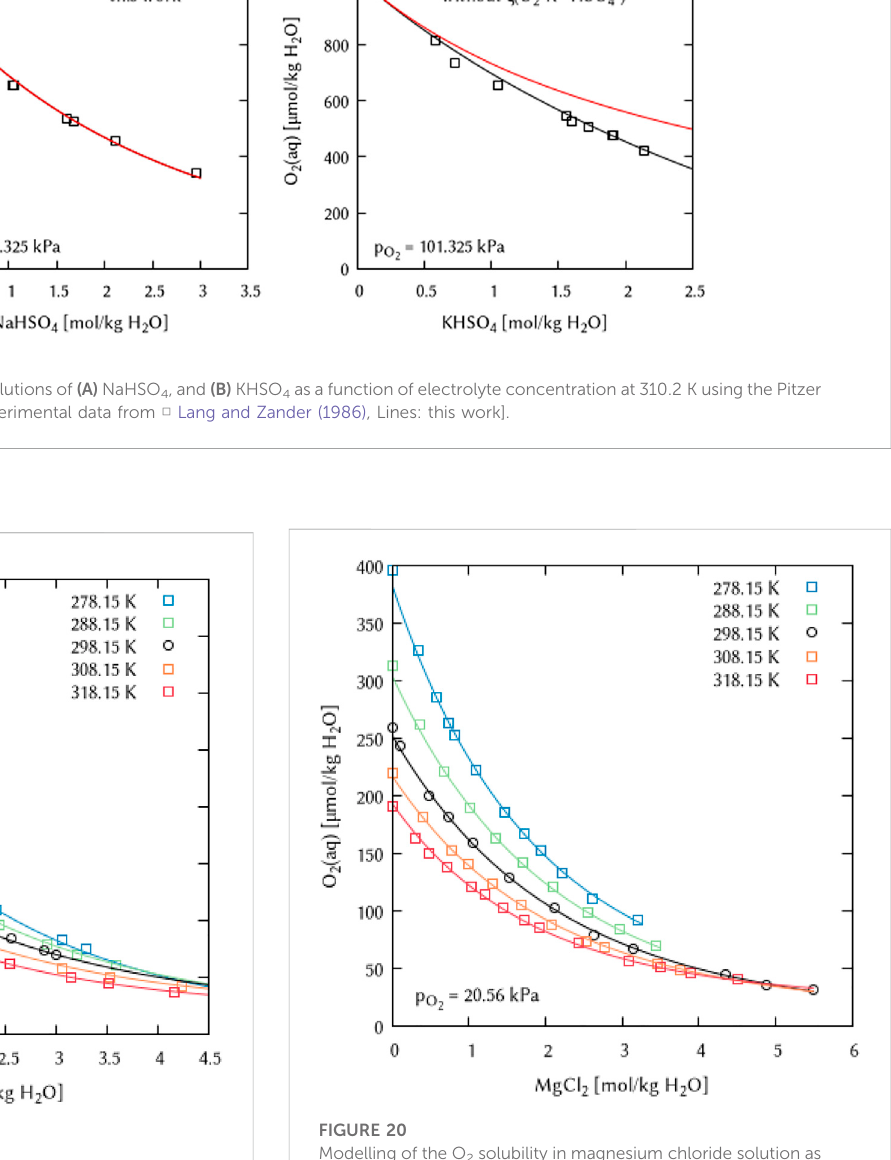
function of temperature and CaCl 2 concentration. [Points: Experimentaldatafrom ○ Milleroetal.(2003)and □ MilleroandHuang (2003), Lines: this work].